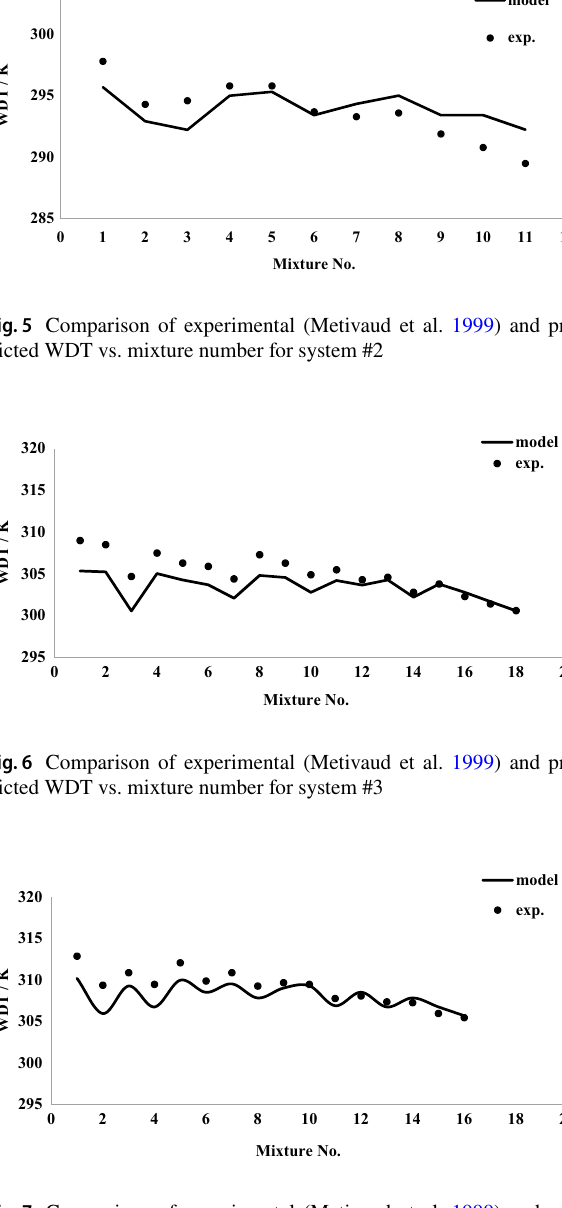
Fig. 7 Comparison of experimental (Metivaud et al. 1999) and pre- dicted WDT vs. mixture number for system